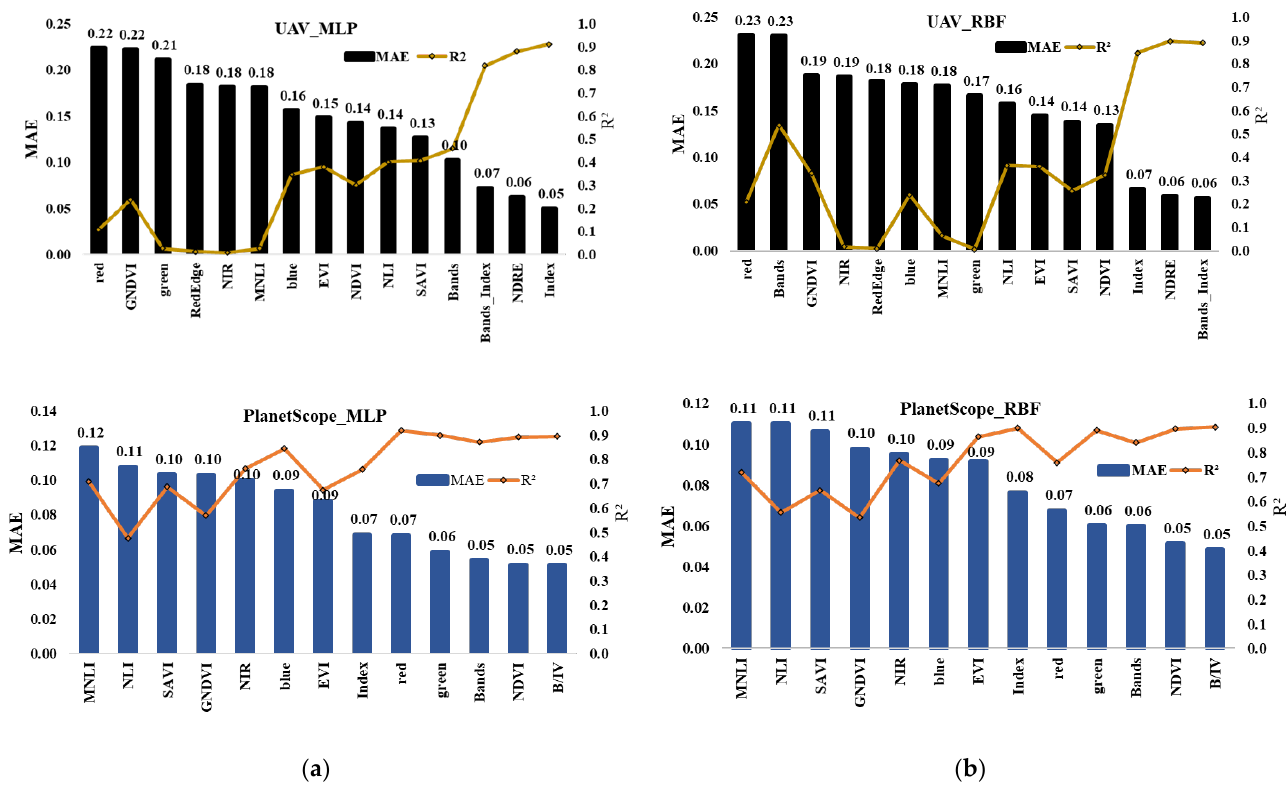
Figure 4. Accuracy (Mean Absolute Error) and precision (R²) of the model validation for the networks: ( a ) multi-layer perceptron-MLP; ( b ) radial basis activation-RBF neural networks.